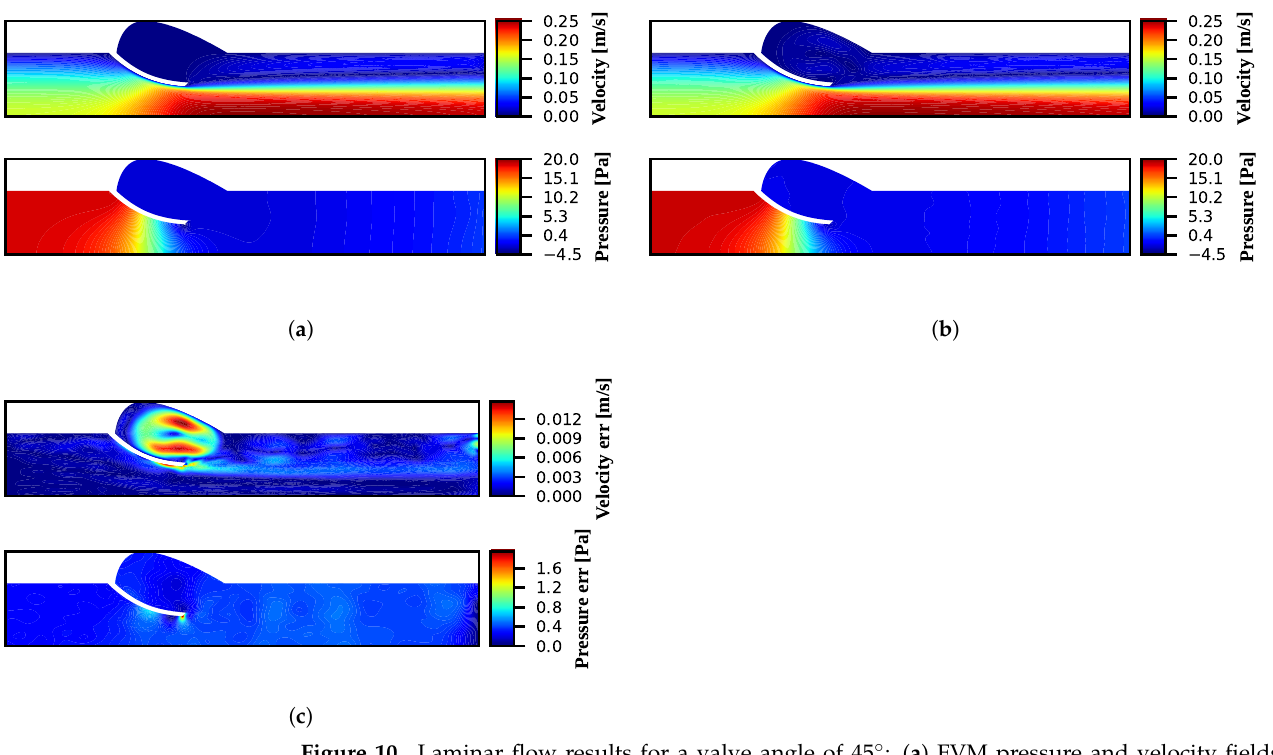
Figure 10. Laminar flow results for a valve angle of 45 ◦ : ( a ) FVM pressure and velocity fields; ( b ) PINN pressure and velocity fields; ( c ) absolute difference between the fields predicted by the PINN and FVM. Table 3. Simulation Cases: